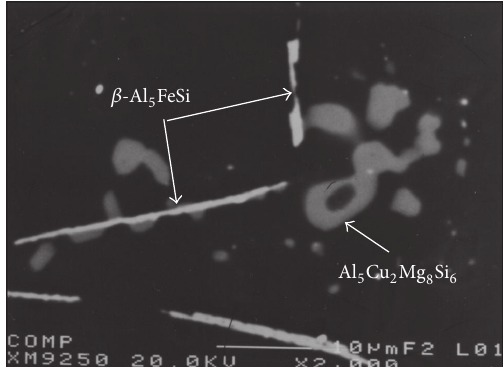
Figure 7: Backscattered electron image of DCM5 alloy solutionized at 490 ∘